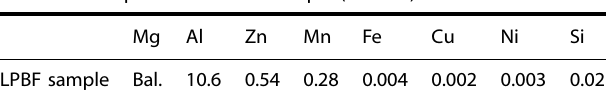
Fig. 7 Aluminium enrichment at the surface after immersion in orthophosphoric acid solution (pH = 2.5). SEM images and corresponding EDXS maps of Al and O elements after LPBF-AZ111 was immersed for ( a – c ) 24 and ( d – f ) 72 h. Scale bars in a and d indicate 2 µm, and in b , c , e , f indicate 5 µm. Table 1. Composition of LPBF sample (in